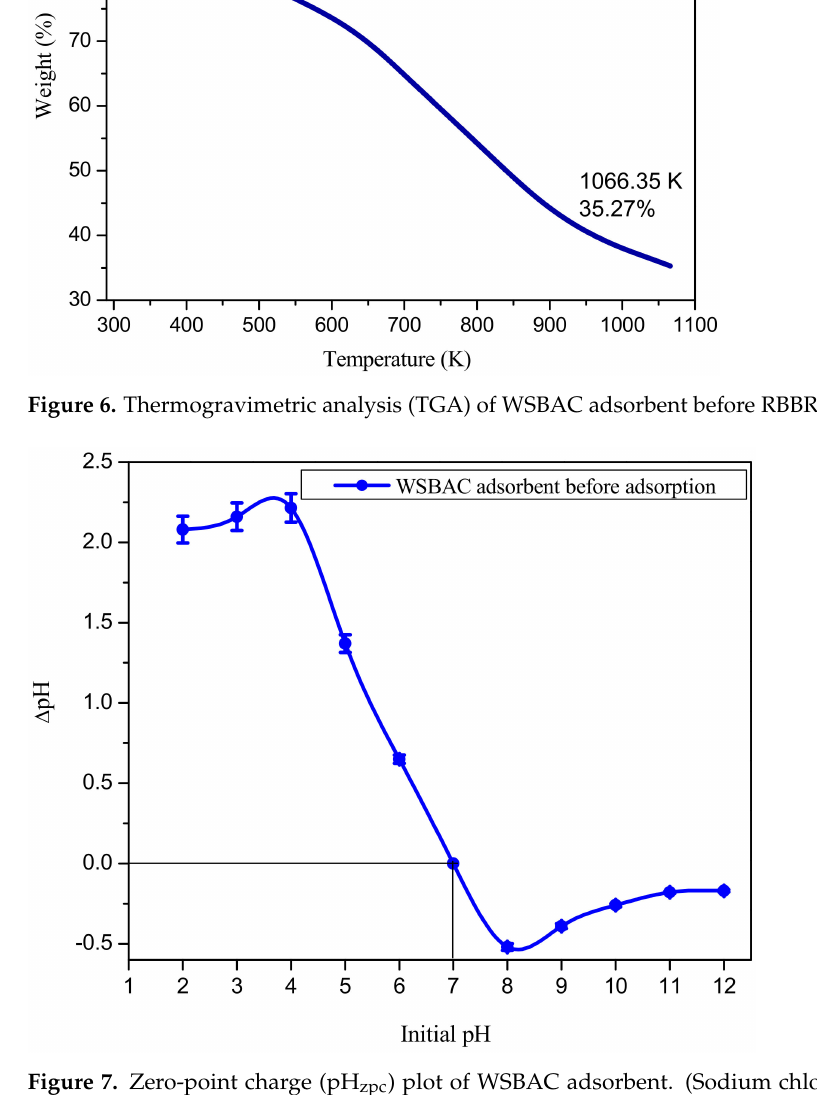
Figure 7. Zero-point charge (pH zpc ) plot of WSBAC adsorbent. (Sodium chloride concentration: 0.1 M; WSBAC: 10 g L − 1 ; adsorbent particle size: 55 µ m; agitation speed: 150 rpm: temperature: 301 K; contact time 24